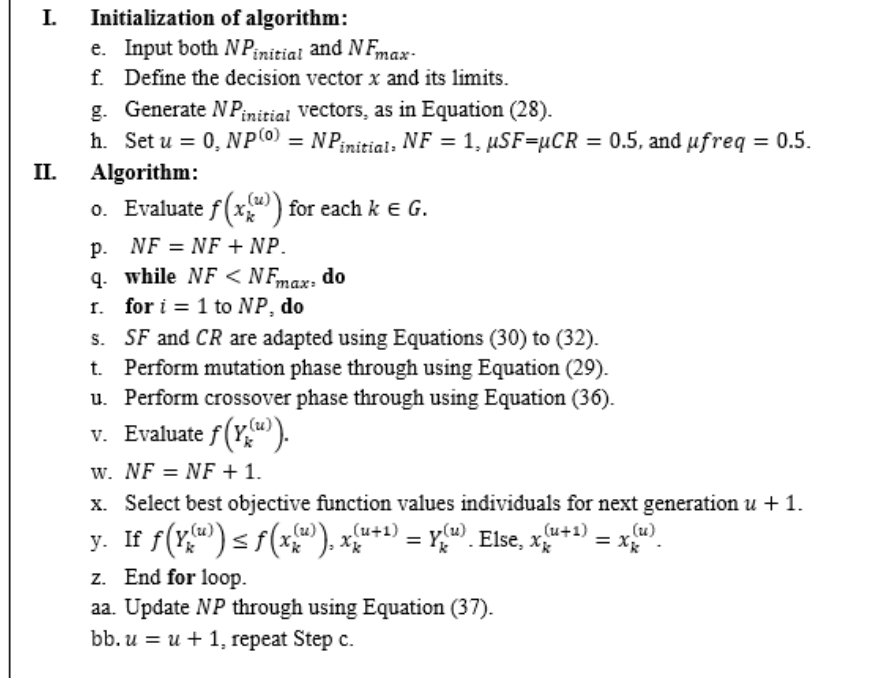
Figure 12. The stages in the pseudo-code of the LSHADE optimizer